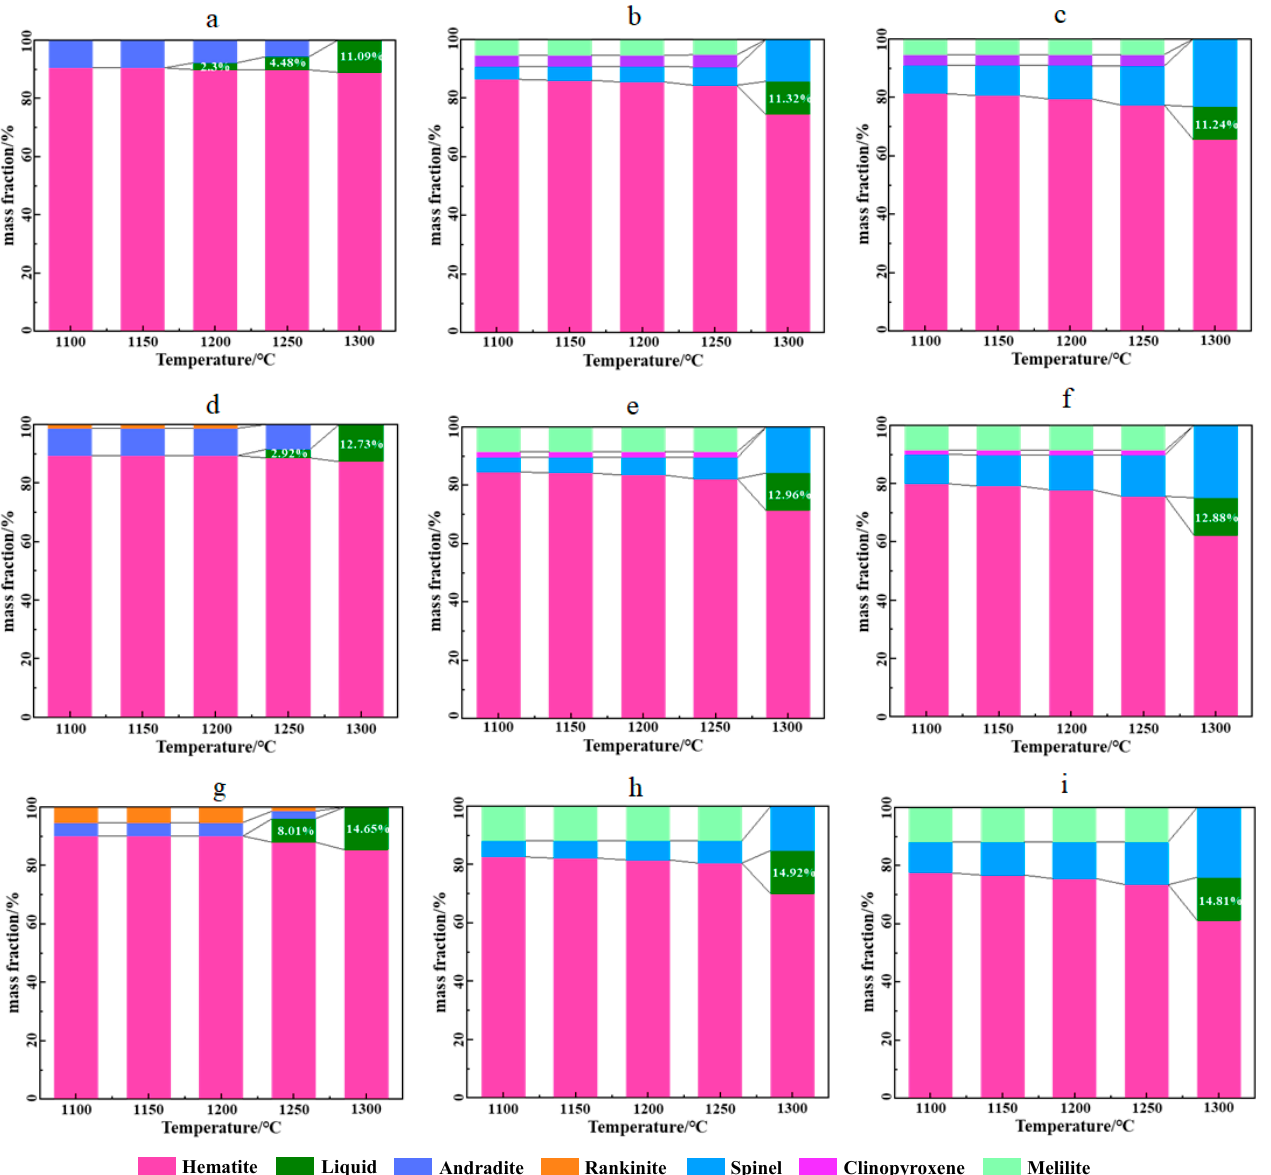
Figure 4. Equilibrium product calculation: ( A ) basicity 0.8, MgO 0 wt%; ( B ) basicity 0.8, MgO 2 wt%; ( C ) basicity 0.8, MgO 3 wt%; ( D ) basicity 1.0, MgO 0 wt%; ( E ) basicity 1.0, MgO 2 wt%; ( F ) basicity 1.0, MgO 3 wt%; ( G ) basicity 1.2, MgO 0 wt%; ( H ) basicity 1.2, MgO 2 wt%; and ( I ) basicity 1.2, MgO 3 wt%.